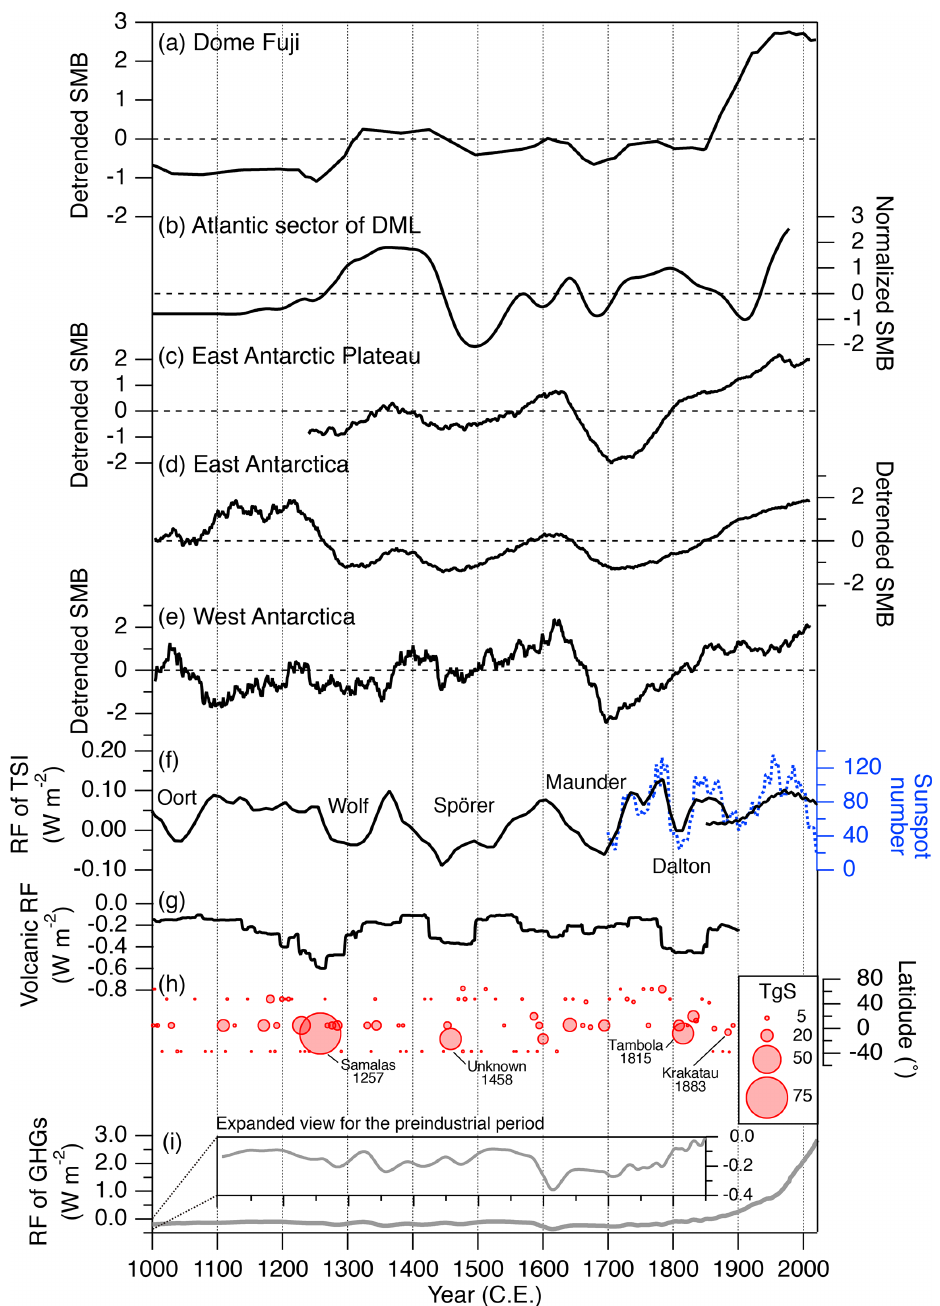
Figure 13. Detrended SMB for the last 1000 years for (a) Dome Fuji, (b) the Atlantic sector of DML (Hofstede et al., 2004), (c) the East Antarctic Plateau (detrended EAP SMB of Thomas et al., 2017), (d) East Antarctica (detrended EA SMB of Thomas et al., 2017) and (e) West Antarctica (detrended WA SMB of Thomas et al., 2017). Also shown are (f) radiative forcing (RF) of total solar irradiance relative to 1750CE (black, Wu et al., 2018) and sunspot number, (g) mean volcanic RF at 40–90 ◦ S with a 71-year moving average, (h) stratospheric sulfur injections from volcanic eruptions (Sigl et al., 2022), and (i) RF of greenhouse gases (CO 2 , CH 4 and N 2 O) relative to 1750CE. Total solar irradiance (TSI, 1000–1885CE) and sunspot number data (1700–2021CE) are from the Max Planck Institute for Solar System Research “Solar Variability and Climate” group (https://doi.org/10.17617/1.5U) and the World Data Center SILSO at the Royal Observatory of Belgium in Brussels (https://www.sidc.be/silso/datafiles, last access: 29 January 2023). The TSI of 1850–2020CE is from Matthes et al. (2017). Volcanic RF was calculated by stratospheric aerosol optical depth (Sigl et al., 2022) and a conversion factor (Hansen et al., 2005). RF of GHGs was calculated using CO 2 , CH 4 and N 2 O concentrations from Rubino et al. (2019) and equations proposed by Etminan et al.